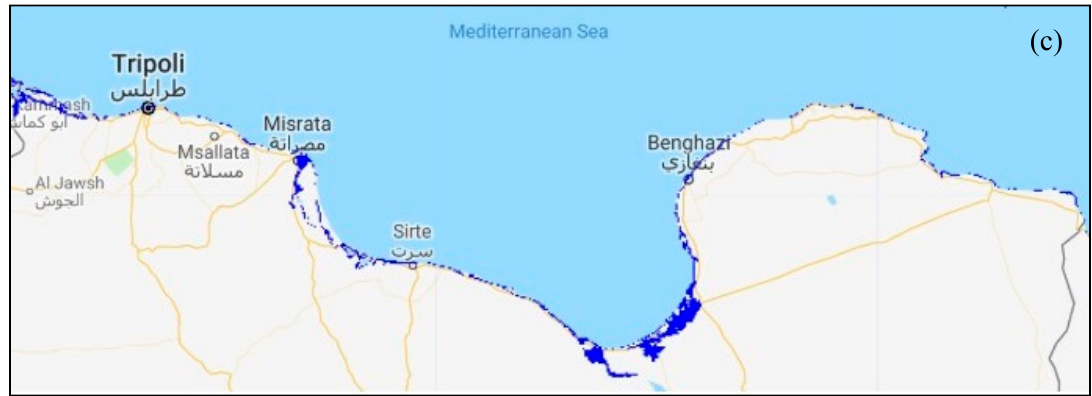
Figure 14. Projections of the future sea rise due to climate change along the Mediterranean Sea coast of Libya: ( a ) 1 m sea rise (affected area: 700 km 2 ), ( b ) 3 m sea rise (affected area: 3200 km 2 ), ( c ) 6 m sea rise (affected area: 7200 km 2 ).